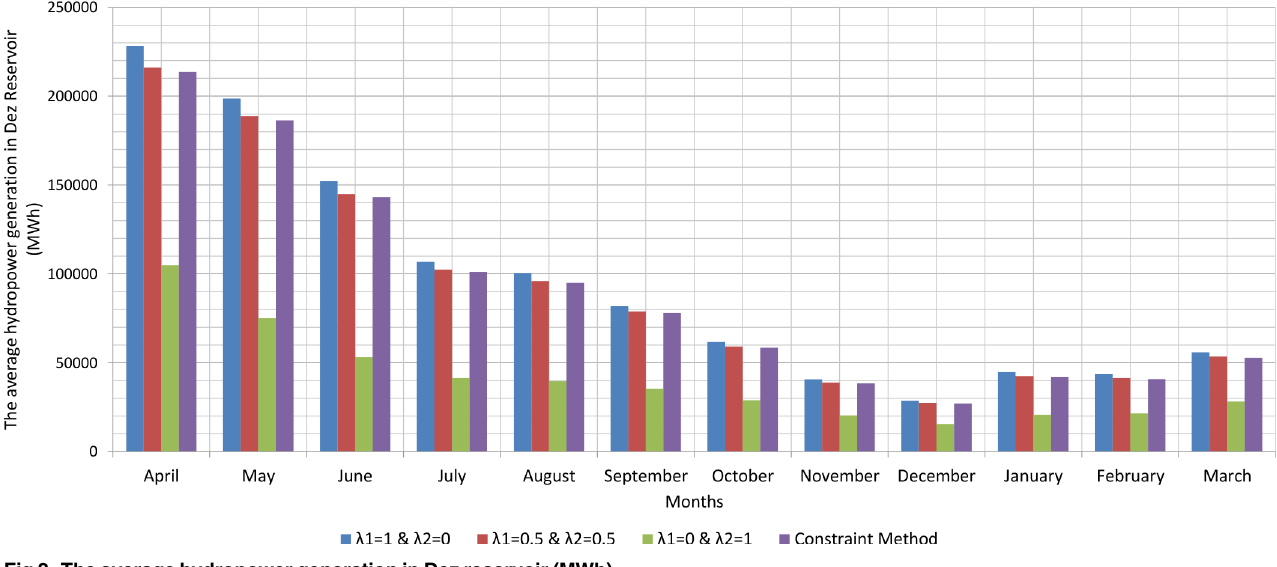
Fig 2. The average hydropower generation in Dez reservoir (MWh).